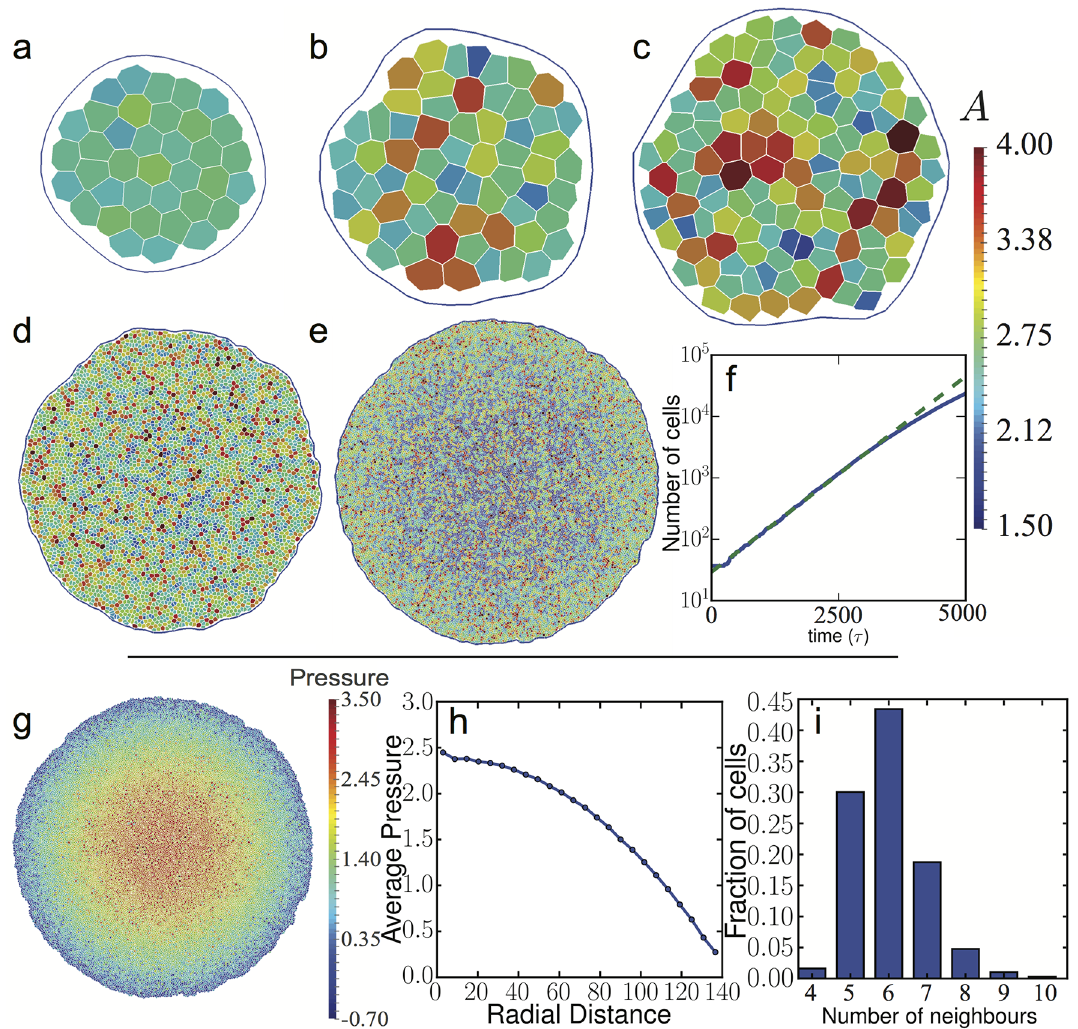
Fig 8. Snapshots of a growing epithelial tissue. Frames (a), (b), (c), (d) and (e) have 37, 63, 124, 4633 and 23787 cells and are at times 50, 500, 1000, 3500 and 5000, respectively. Cells have a chance to divide if their area is greater than a critical area A c = 2.8 a 2 after which the probabilityof a cell to divideincreaseslinearlywith its area (see Eq (16)). In this simulation, the shapefactor was set to p 0 = 3.10. (f) Log-linearplot of the total numberof cells as a function of simulation time. The growth rate of the patch is initiallyexponential but starts to slow at around3000 cells. This is due to cells in the centre of the cluster being prevented from expanding by the surrounding tissue. (g) Tissue after 5000time units (10 6 time steps) with each cell colouredby pressure. Pressure has built up in the centre of the tissue whileclose to the edge the averagepressureis low. (h) Average pressure (averagedover the polar angle) as a function of the radial distancefrom the centre of the tissue. (i) Distributionof the numberof neighboursfor cells in the system shown in